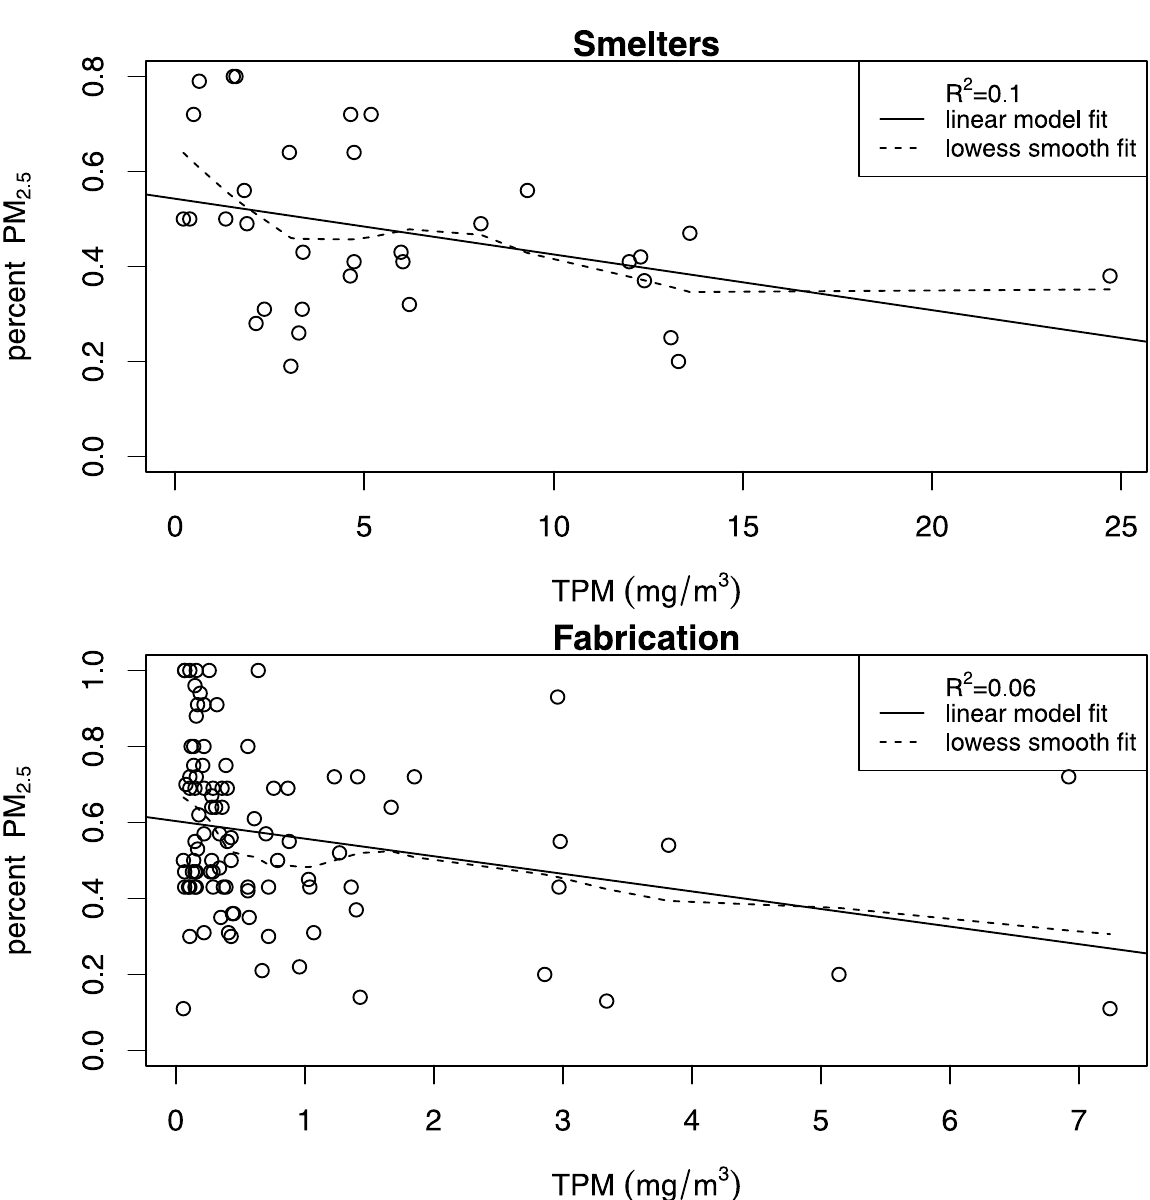
Fig 2. Scatterplot of TPM and percent PM 2.5 for distinct exposure groups based on an aluminum industry JEM, for two different facility types: smelters (33 DEGs) and fabrication (99 DEGs). Solid lines represent a line of best fit, and the dashed line is a lowess line. Information in this figure is restricted to exposure groups with high confidence exposure values for both TPM and PM 2.5